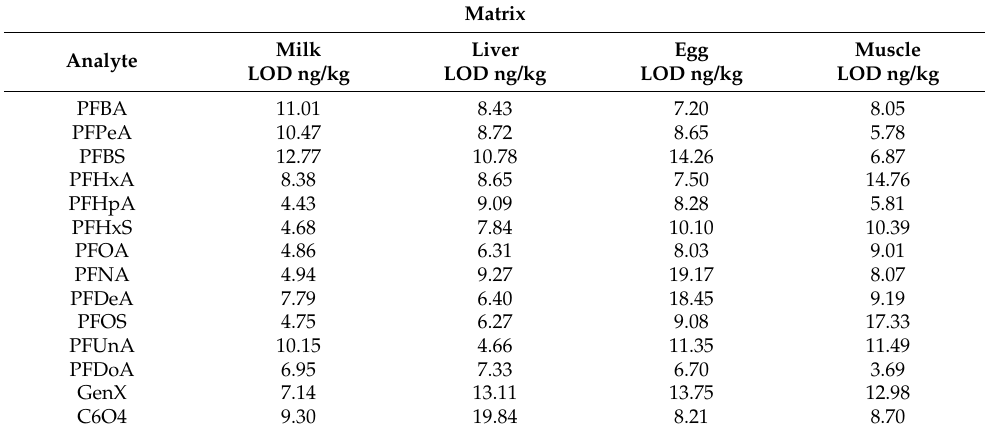
Table 3. Limit of detection (LOD) calculated according to the calibration approach.